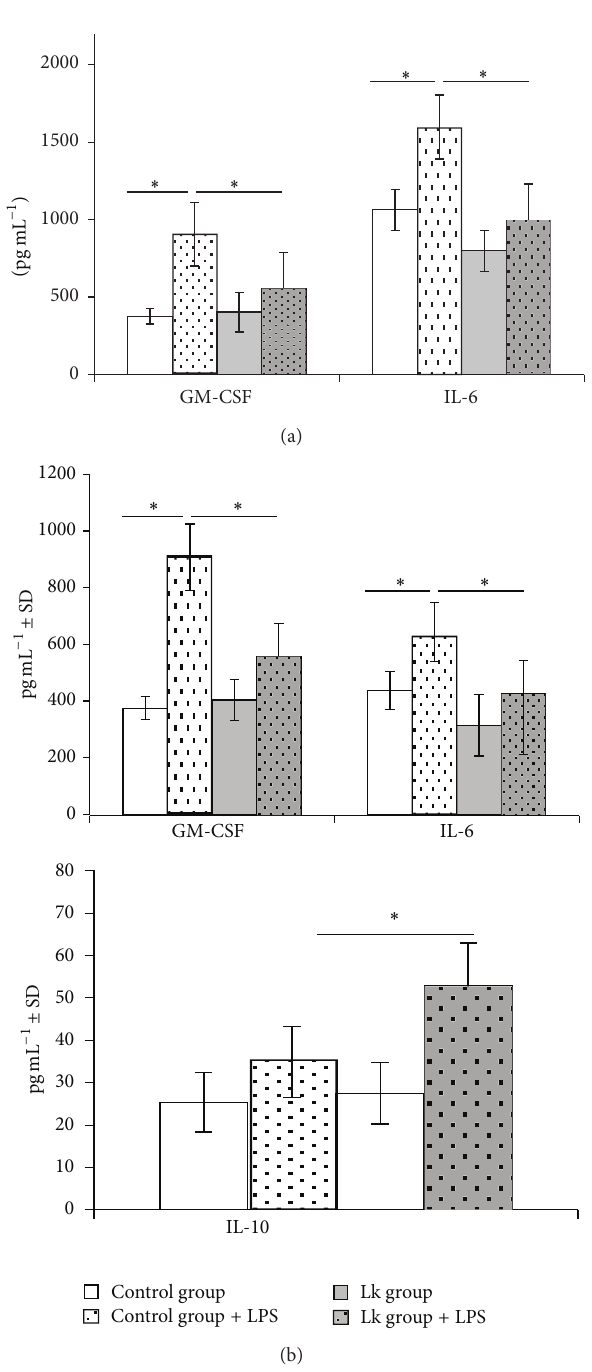
Figure 5: Cytokine’s release in supernatants of (a) ileum and (b) colonic explants cultured for 24 h in the presence of LPS. Results are expressed as mean ± standard deviation. ∗ 𝑃 < 0.05